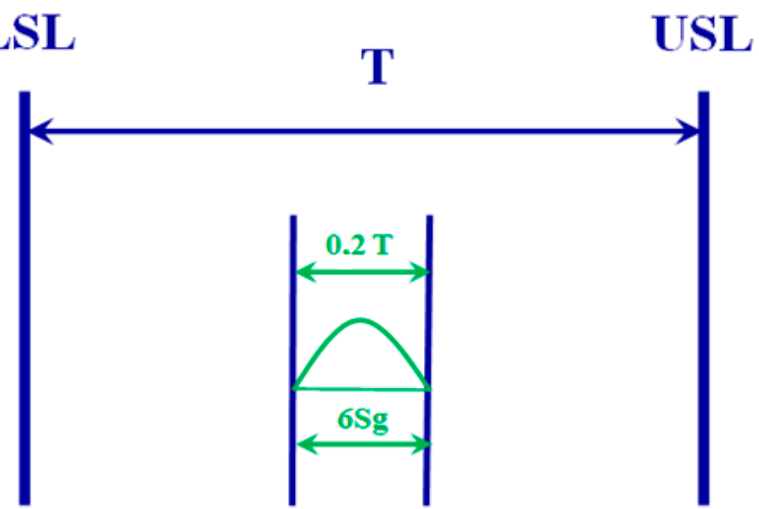
Figure 17. Interpretation of the 20 percent tolerance for repeatability of measuring equipment (own study).